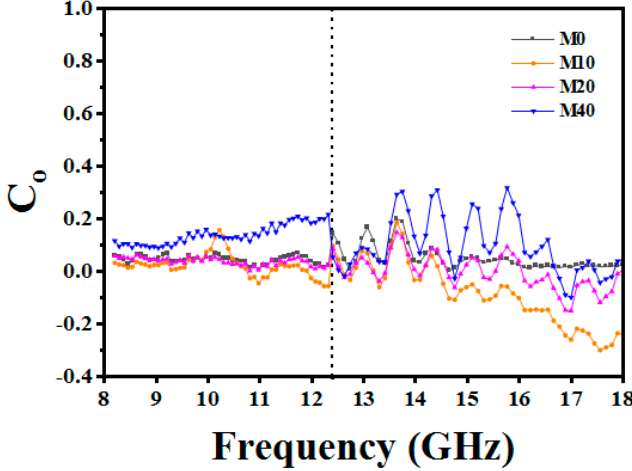
− 2 − 1 f values for all samples.